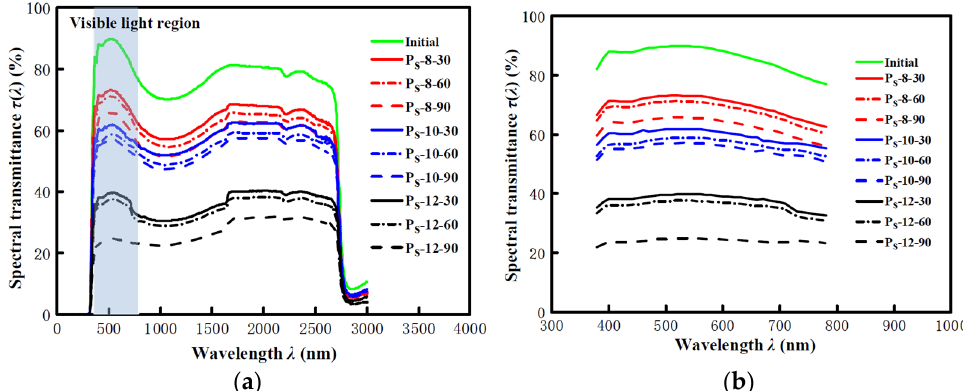
Figure 8. Spectral transmittance τ ( λ ) of the glass specimens without and with erosion for 5 s: ( a ) full spectral transmittance τ ( λ ) (300 nm ≤ λ ≤ 3000 nm) of glass specimens without and with erosion for 5 s and ( b ) visible spectral transmittance τ ( λ ) (380 nm ≤ λ ≤ 780 nm) of glass specimens without and with erosion for 5 s.